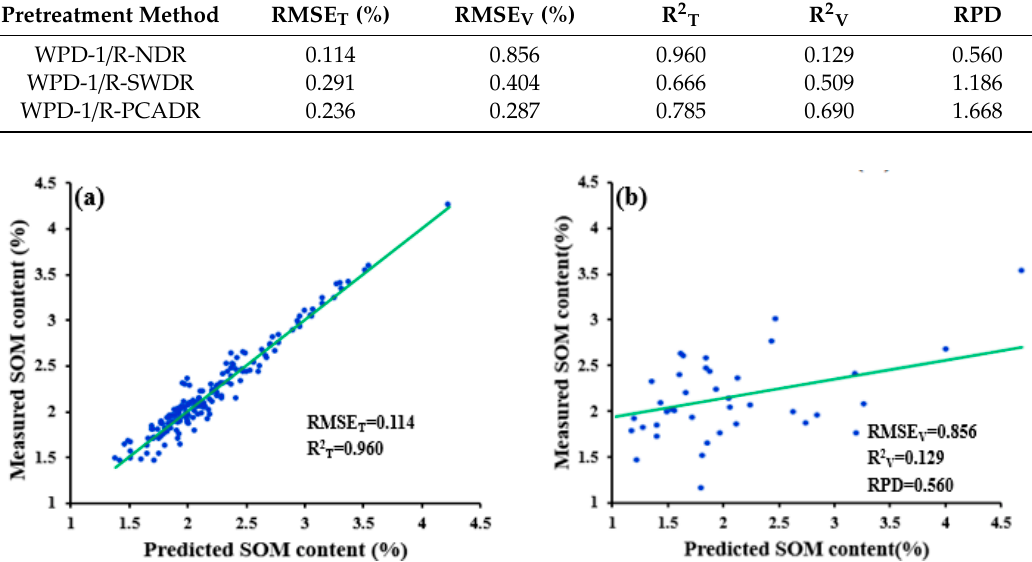
Table 6. Comparison of SOM Content Estimation Results for Spectral Data Subjected to 1 / R Transformation, WPD Denoising, and Di ff erent Dimensionality Reduction Methods.